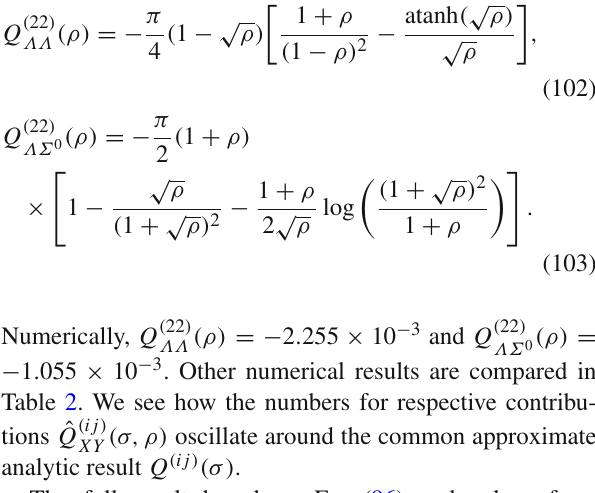
Table 2. We see how the numbers for respective contribu- ( ij ) ˆ (σ, ρ) oscillate around the common approximate Q tions XY analytic result Q ( ij ) (σ) .